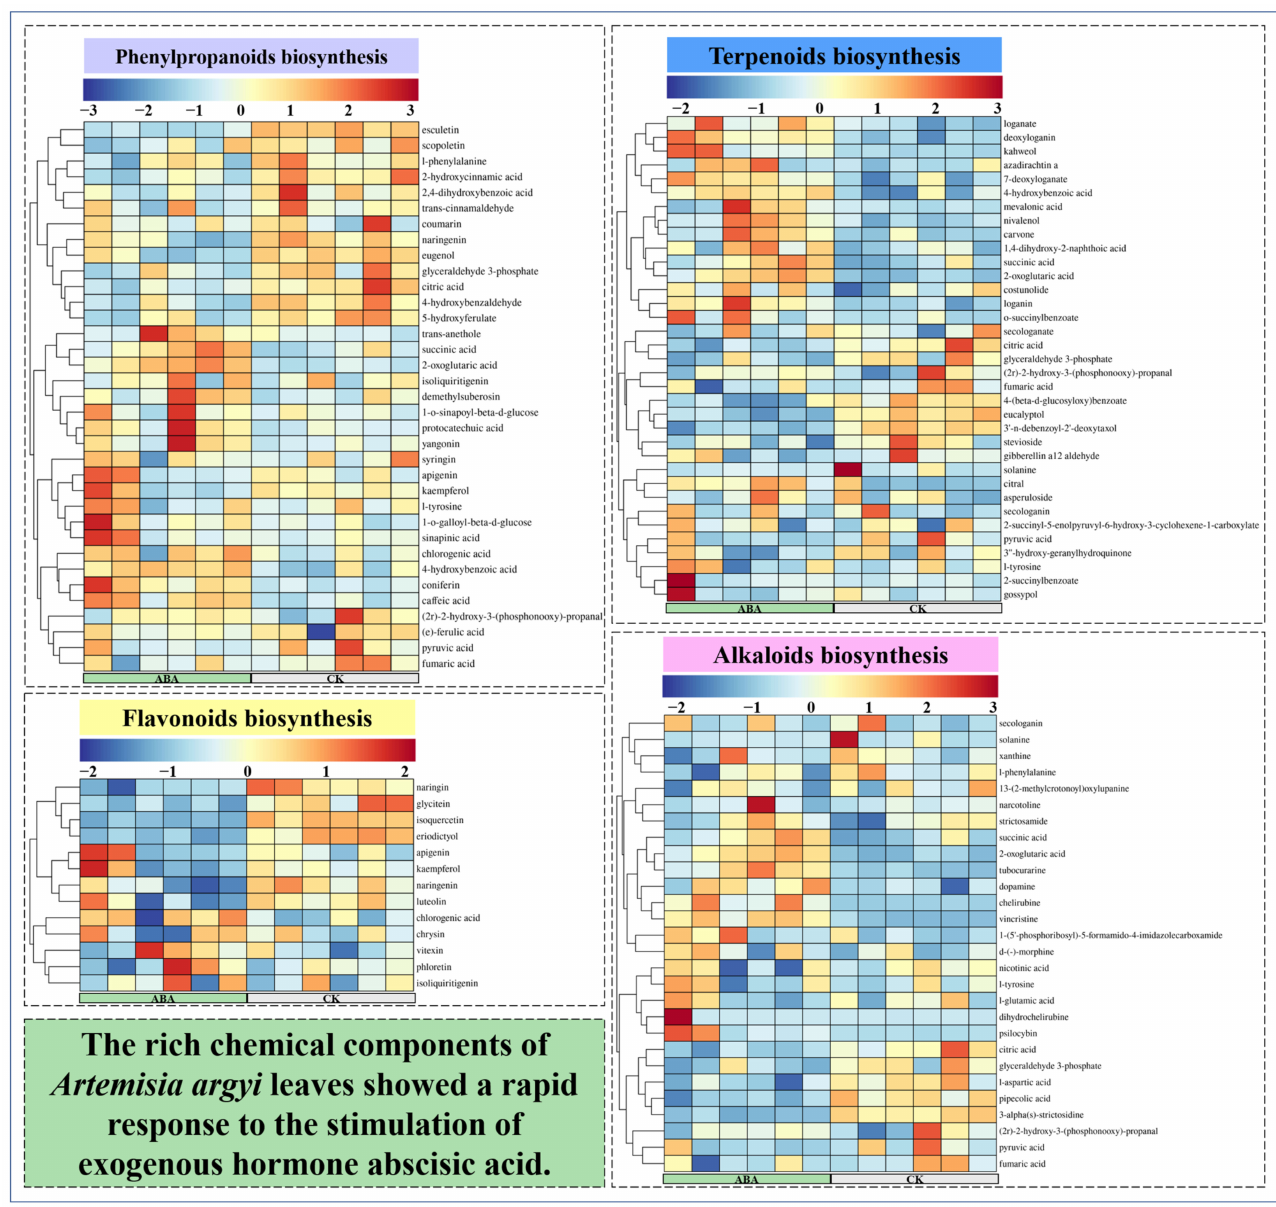
Figure 8. A heatmap of the relative amounts of phenylpropanoid, flavonoid, terpenoid and alkaloid